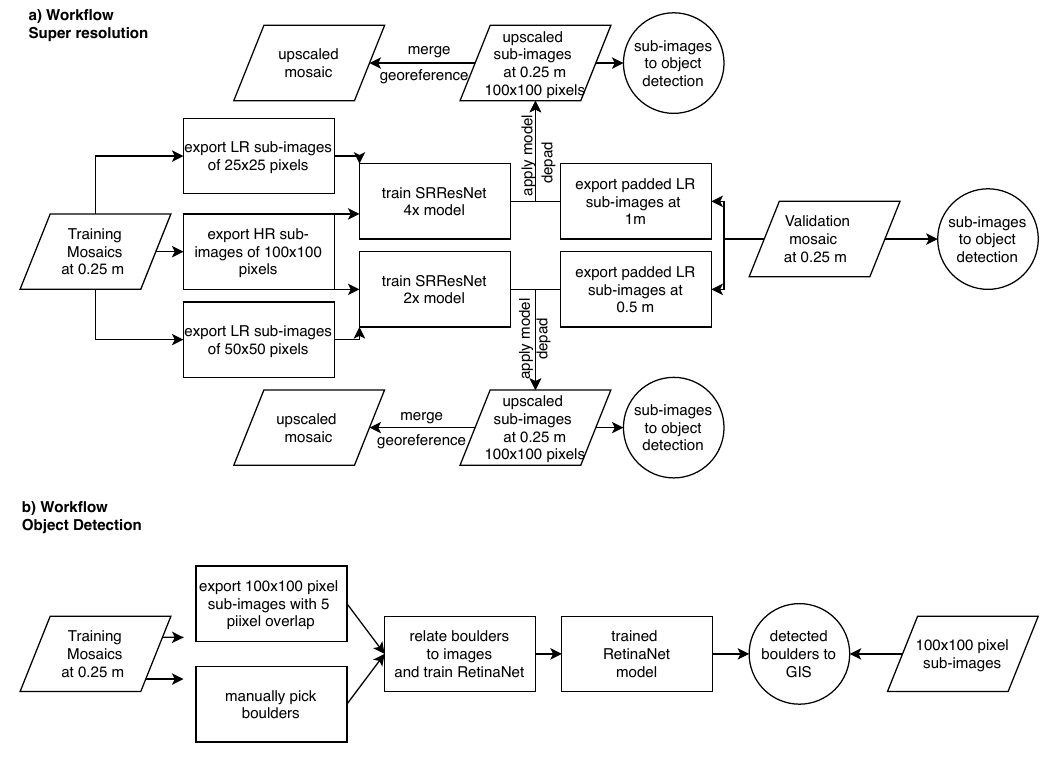
Figure 3. Workflow followed during training of SRResnet ( a ) and RetinaNet ( b